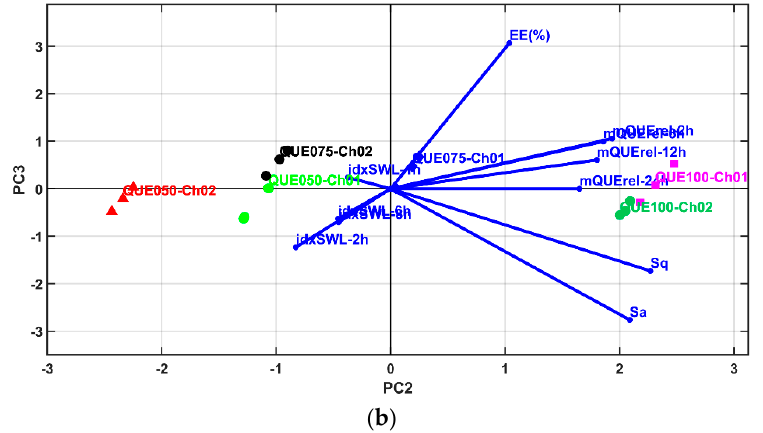
Figure 16. Biplots of PCA results: ( a ) 2D representation for PC1 and PC2 principal components; ( b ) 2D representation for PC2 and PC3 principal components.